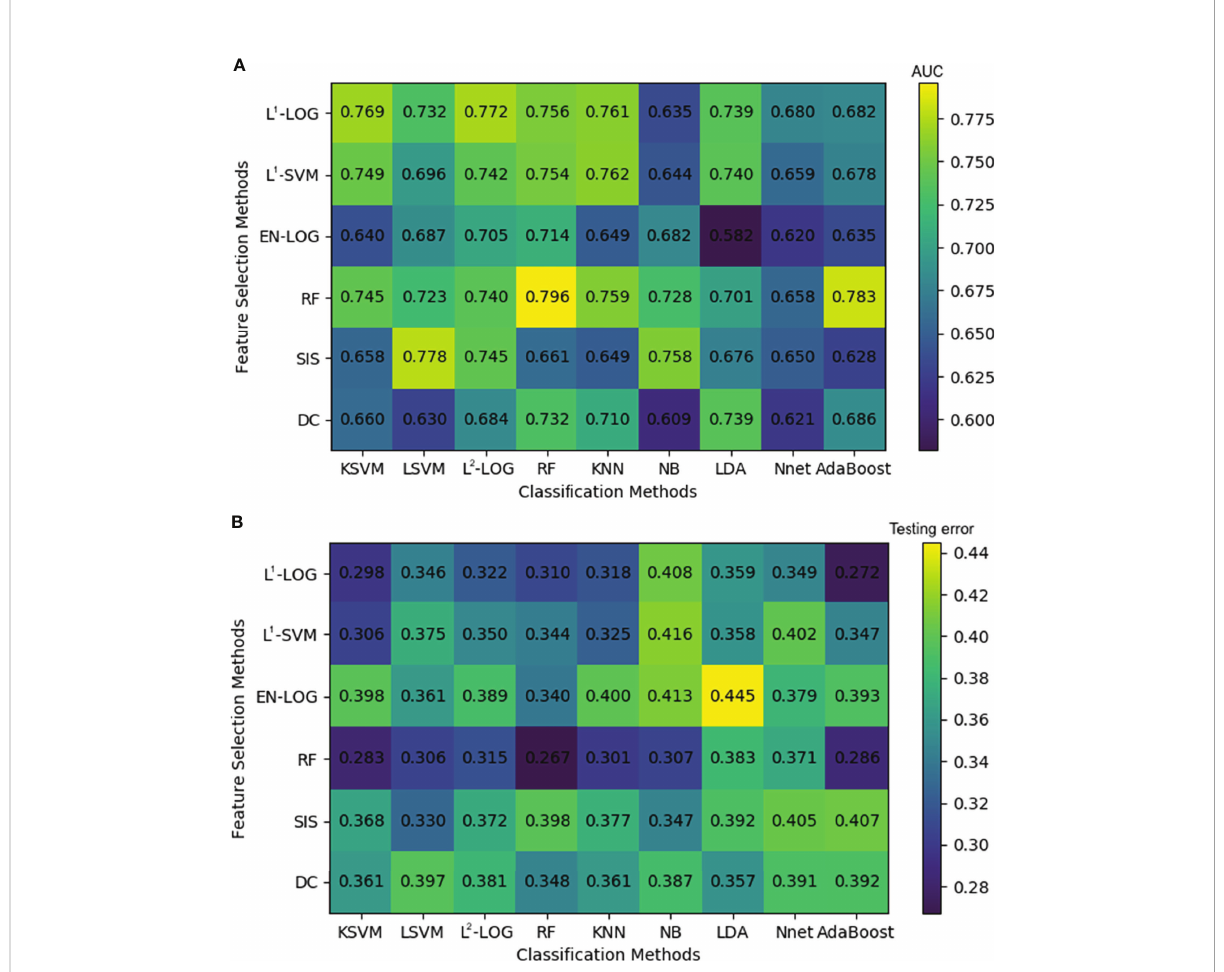
FIGURE 4 A heatmap depicting the mean internal validation AUC (A) and testing error (B) of all 54 cross-combinations derived from six feature selection methods (in rows) and nine classi fi cation methods (in columns). AUC, area under the receiver operating characteristic